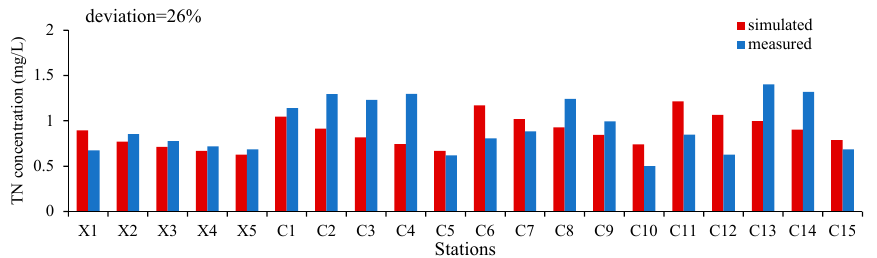
Figure 5. The simulated results compared with measured data at selected stations in May 2014.